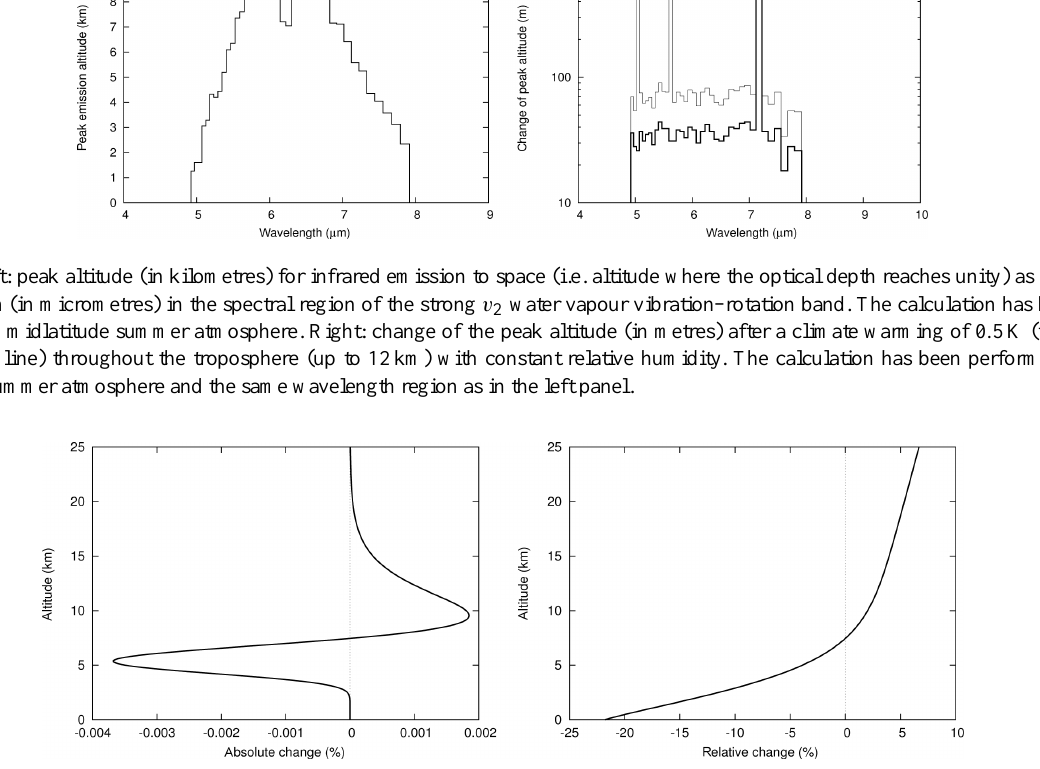
Figure 3. Absolute (left) and relative (right) change of altitude dependent weights in the kernel function (Eq. 1) after an increase of z from 7 . 00 to 7 . 05km and a small increase of H from 2 . 00 to 2 .